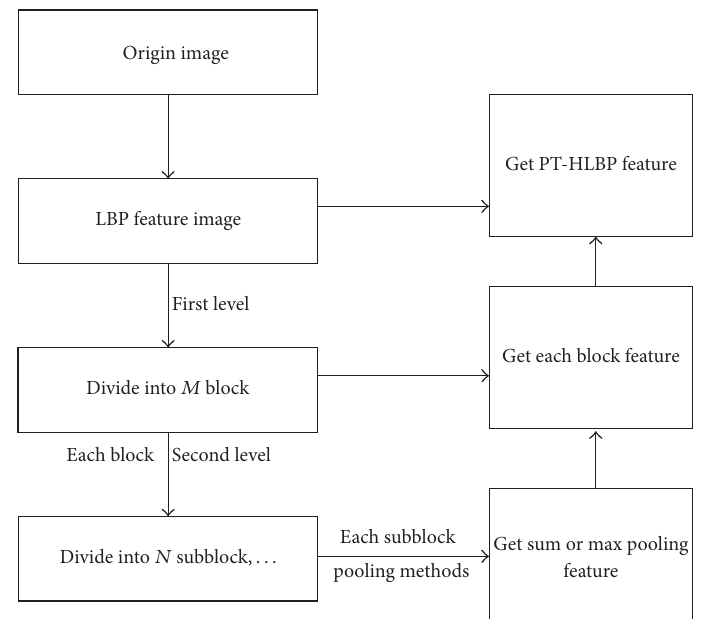
Figure 2: The flow chart of PT-HLBP.